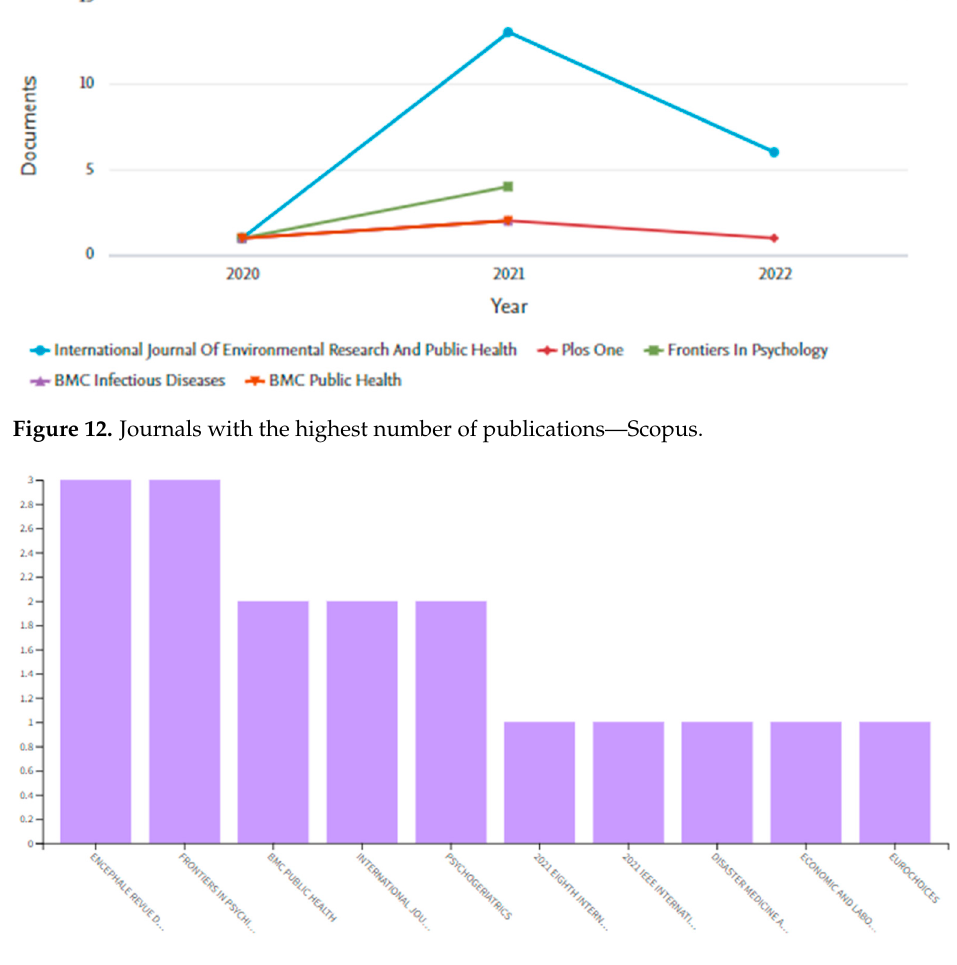
Figure 13. Journals with the highest number of publications—Web of Science.